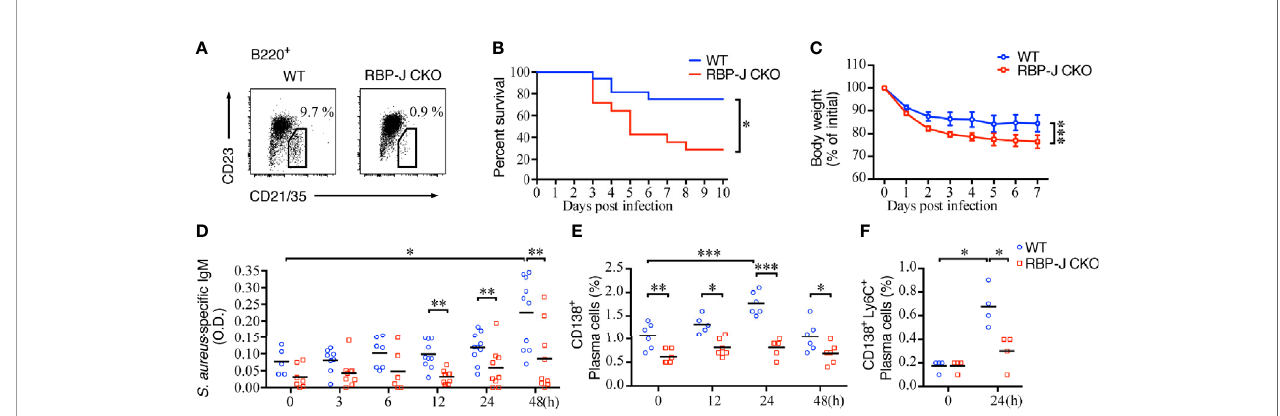
FIGURE 1 | Mortality and S. aureus -speci fi c IgM production in mice lacking MZ B cells. (A) Splenocytes of RBP-J f/f × CD19Cre + (RBP-J CKO) or WT mice were stained with antibodies against B220, CD21/35, and CD23. MZ B cells were de fi ned as B220 + CD21/35 hi CD23 lo by fl ow cytometry. The numbers denote the percentage of MZ B cells in the B220 gate. (B) The survival rates of RBP-J CKO and WT mice were recorded daily after the mice were infected with 5 × 10 6 CFU of S. aureus . The survival rate differences were analyzed by a log-rank (Mantel-Cox) test. (C) The bodyweight loss of mice after they were infected with 2.5 × 10 6 CFU of S. aureus. The statistical analysis was conducted by performing an unpaired t -test (n = 7). (D) ELISA analysis using splenic tissue homogenates to measure the levels of S. aureus -speci fi c IgM in RBP-J CKO and WT mice at various days after infection with 2.5 × 10 6 CFU of S. aureus . The statistical analysis was conducted by performing an unpaired t -test (n = 5 – 10). (E) Differences in the percentages of CD138 + plasma cells in RBP-J CKO and WT mice at the indicated timepoints after S . aureus infection were compared. (F) Differences in the percentage of CD138 + Ly6C + plasma cells in RBP-J CKO and WT mice at 24 h after S. aureus infection. The statistical analysis was conducted by performing an unpaired t-test (n = 4). Data are presented as the mean ± SEM. * p < 0.05, ** p < 0.01, and *** p <